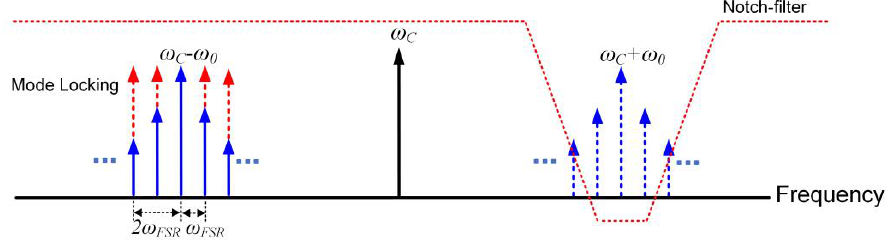
Figure 2. The principle of mode-locking based on the proposed generation system.